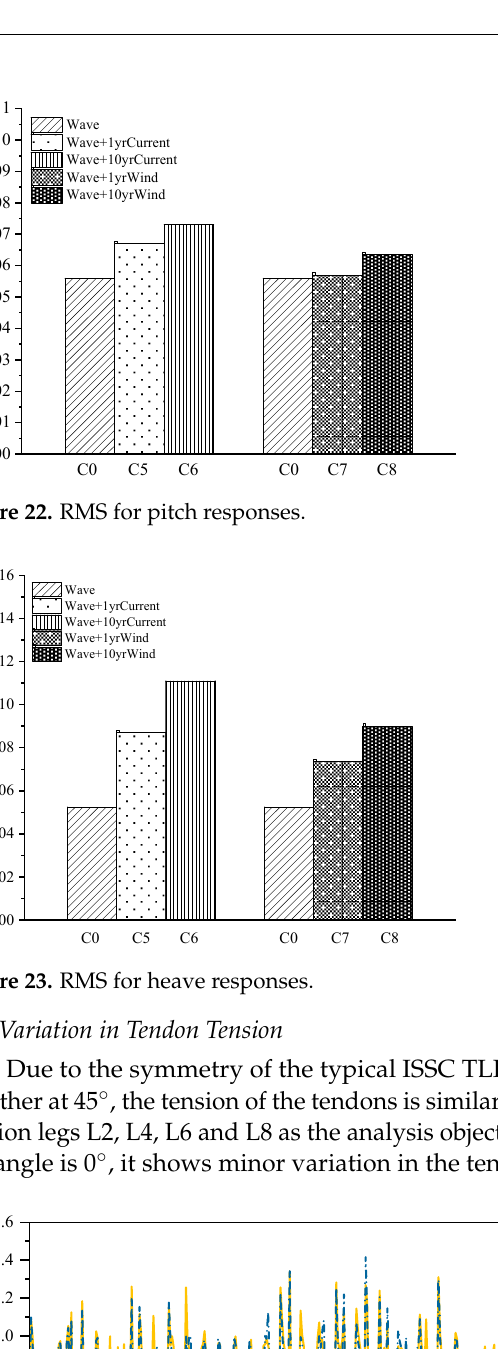
Figure 21. RMS for surge responses.